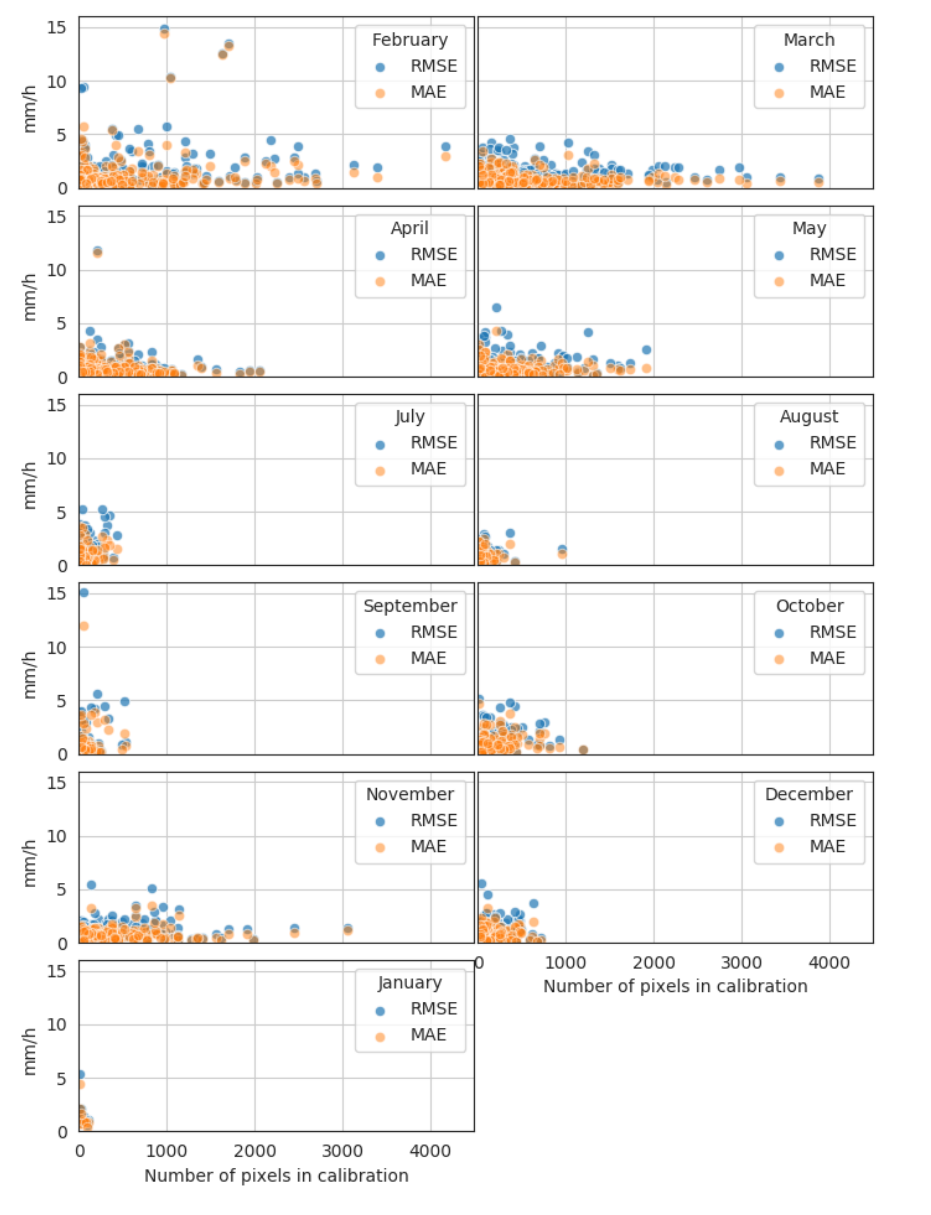
Figure 11. RMSE and MAE values as a function of the number of pixels in the training dataset for different